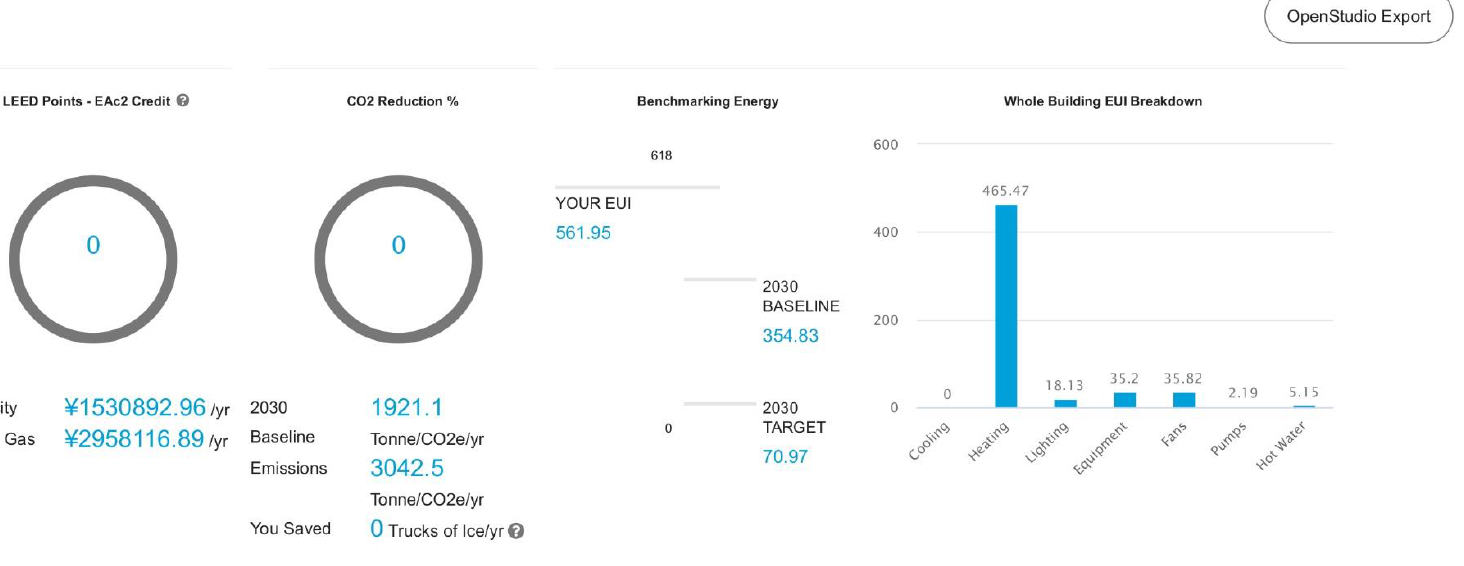
Figure A49. Zone 8-H Yushu, Qinghai (pre-COVID-19 scenario).